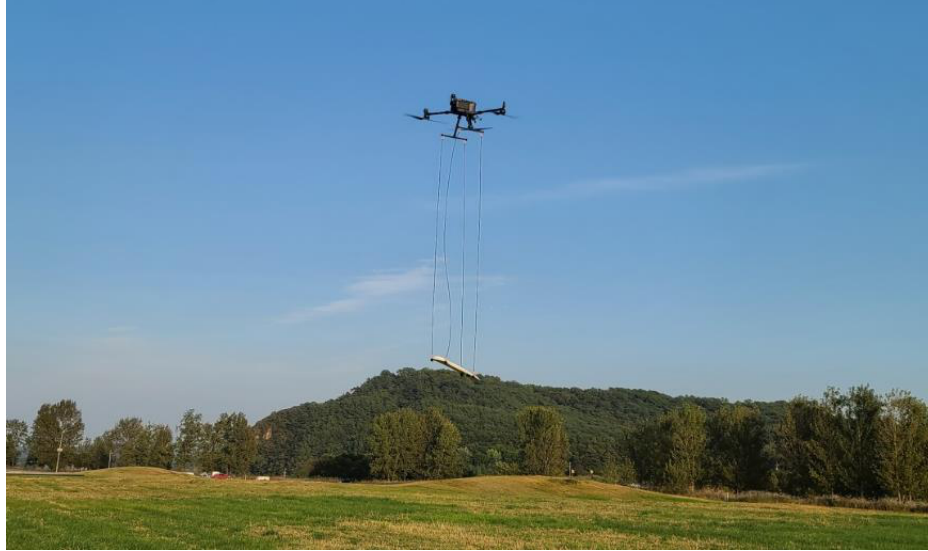
Figure 4. Unmanned aeromagnetic survey system used by KIGAM.